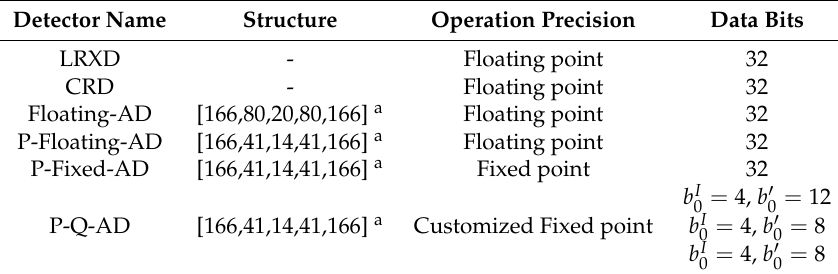
Table 4. The network structure and the operation precision for Local RXD(LRXD), collaborative representation based anomaly detector (CRD), floating point precision without pruning anomaly detectors (Floating-AD), P-Floating-AD, floating point precision with pruning anomaly detectors (P-Fixed-AD), and pruning–quantization–anomaly–detector (P-Q-AD).